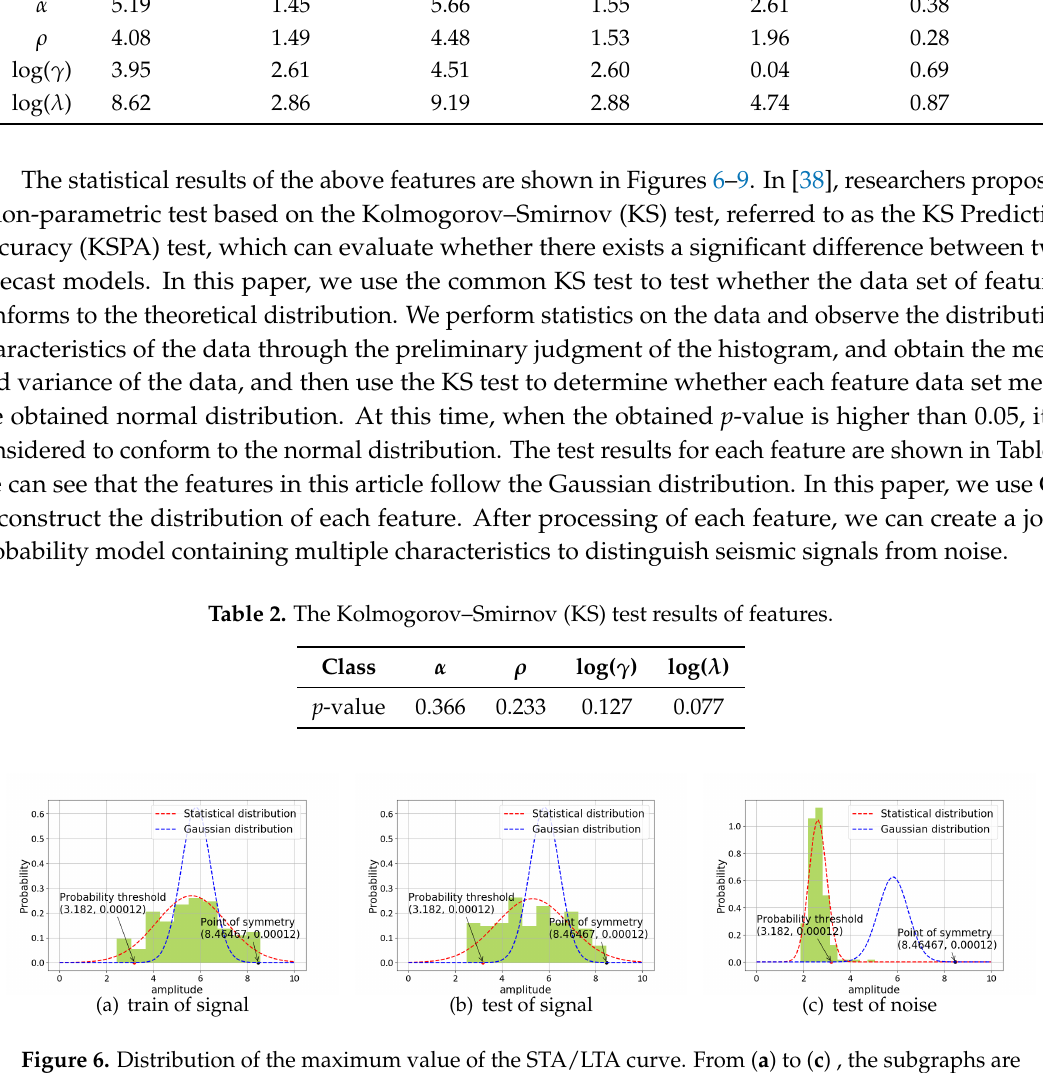
Figure 6. Distribution of the maximum value of the STA/LTA curve. From ( a ) to ( c ) , the subgraphs are the train set data distribution, the seismic test set distribution and the noise test set distribution of the maximum feature. The red dotted line represents the statistical distribution, while the blue dotted line is distribution obtained by the Gaussian process using prior